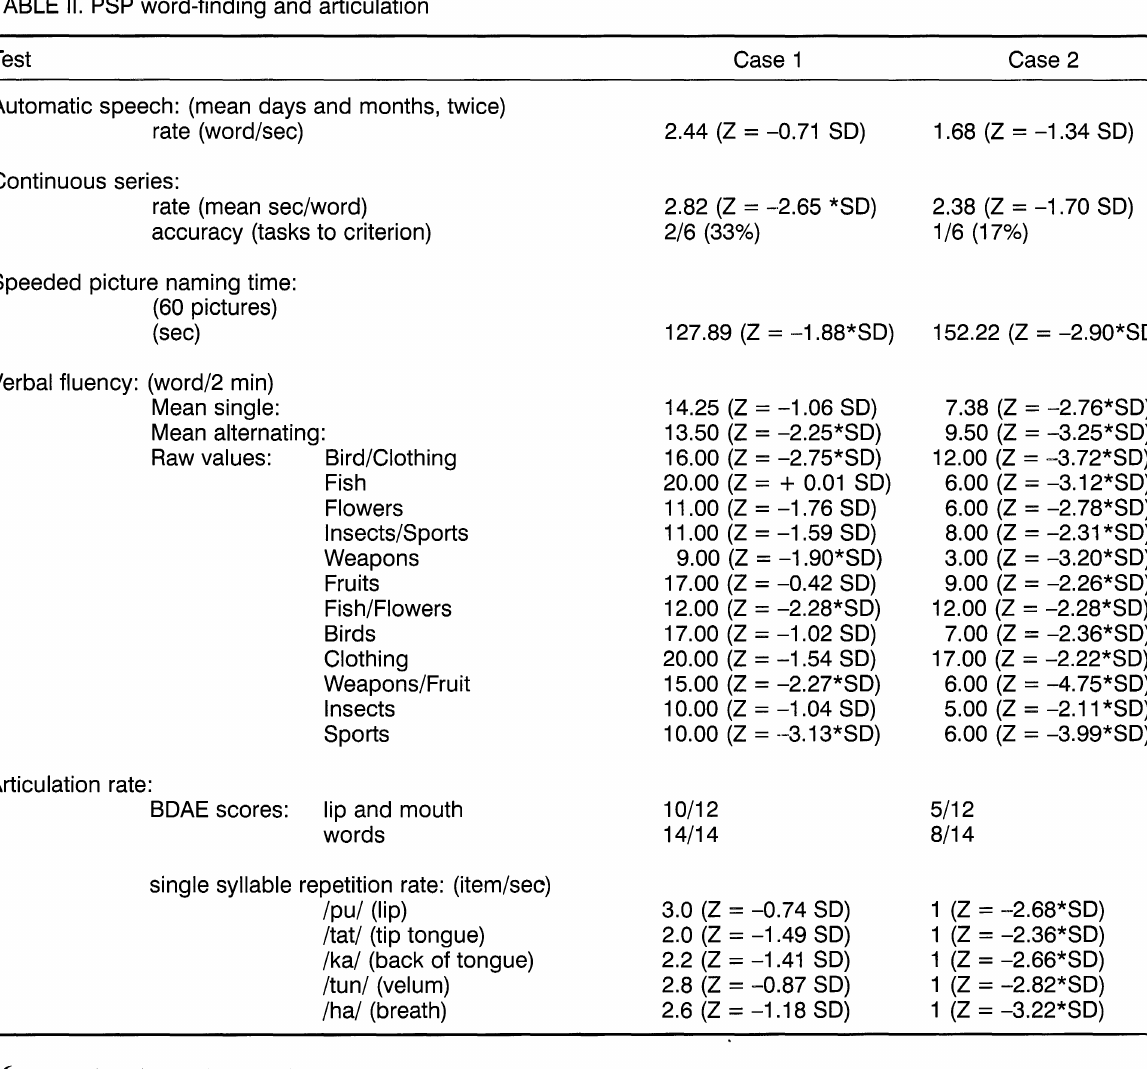
TABLE II. PSP word-finding and articulation Test Automatic speech: (mean days and months,